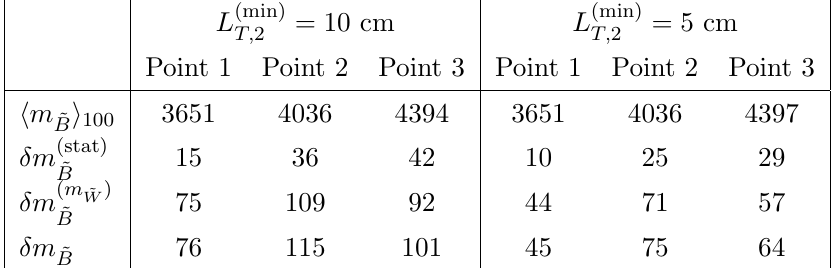
Table 4 . The mean of the peak position based on 100 data sets for each Sample Point, denoted as h m ~ i 100 , as well as the uncertainty in the Bino mass determination (in units of GeV). The total B uncertainty, (cid:14)m ~ , is obtained by adding (cid:14)m (stat) B